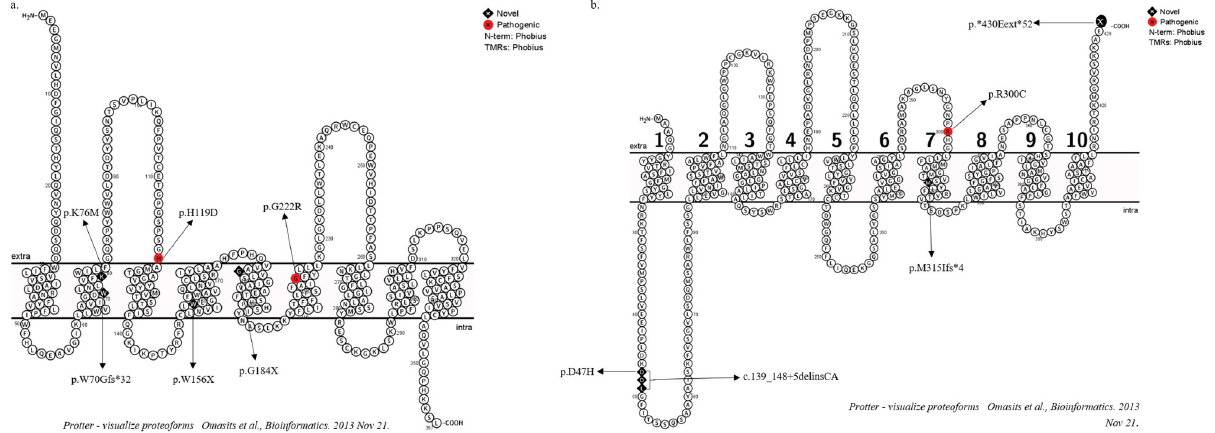
Fig 1. Topology of (a) G6Pase- α enzyme and (b) G6PT enzyme showing all variations identified in this study.